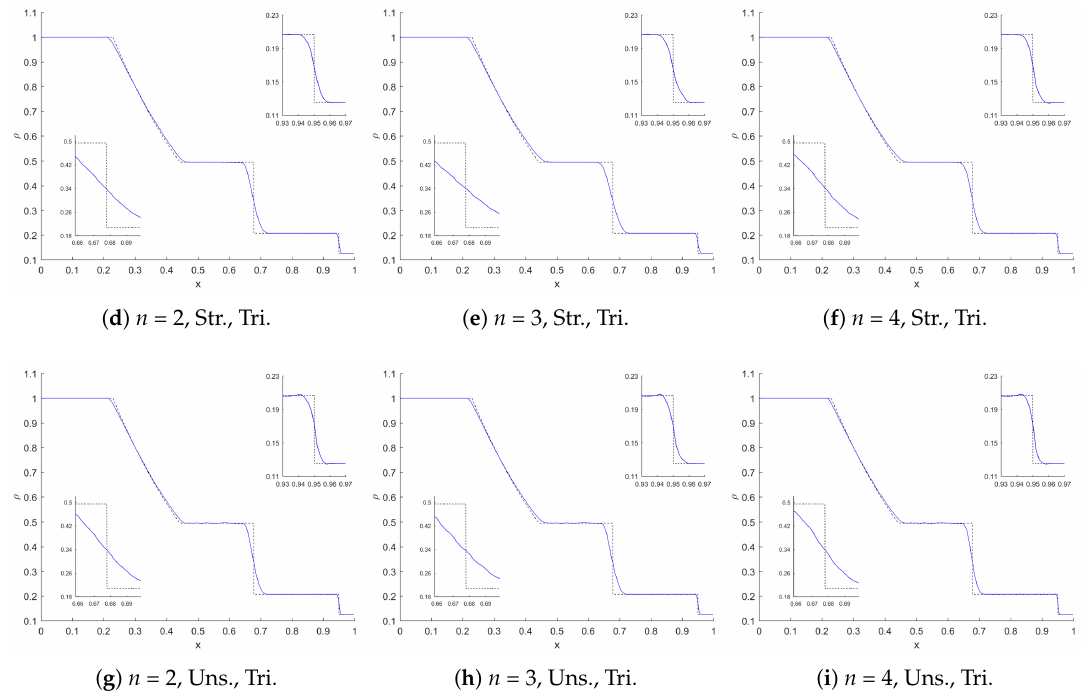
( g ) n = 2, Uns., Tri. ( h ) n = 3, Uns., Tri. ( i ) n = 4, Uns., Tri. Figure 5. Two-dimensional shock tube problem with initial pressure ratio 5.5, various polynomial orders, and different types of grids. In each plot, the top-right inset figure is the result near the shock wave and the bottom-left inset figure is the result near the contact discontinuity.